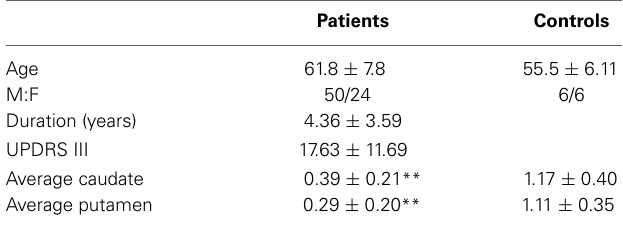
Table 1 | Summary of demographics and mean regional caudate nucleus, putamen 99m Tc-TRODAT-1 BP ND values in PD patients and control